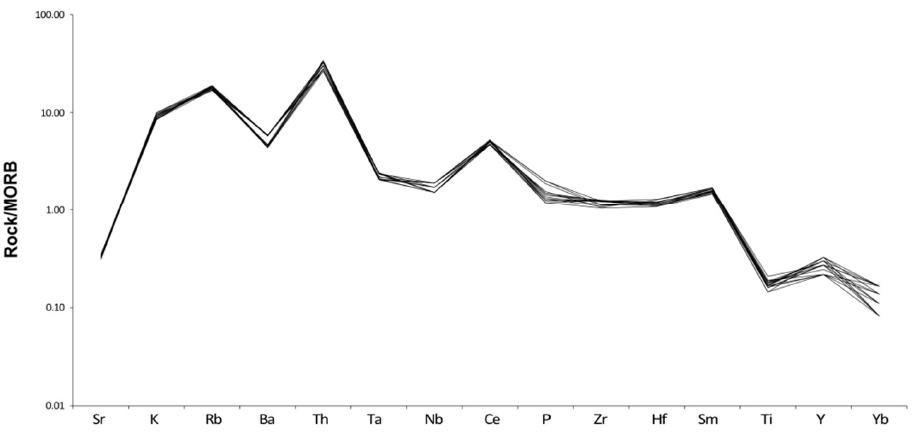
Figure 8. Trace elements MORB normalized spider diagram. Normalization was undertaken with respect to values by Pearce et al. [57].